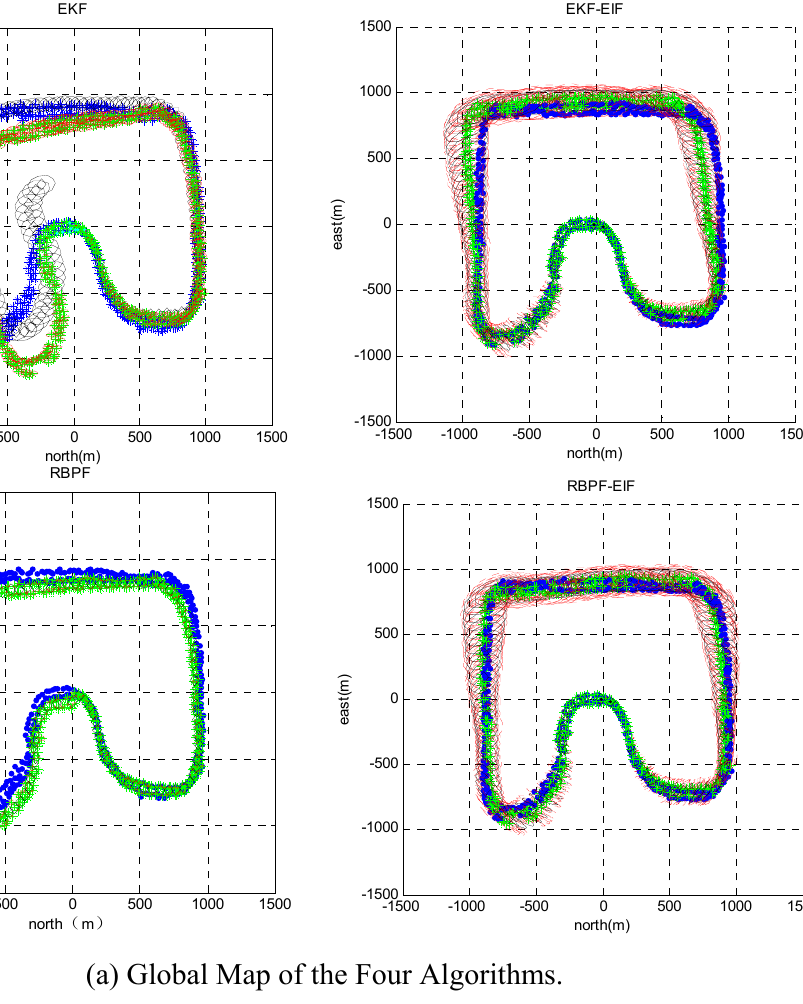
(a) Global Map of the Four Algorithms.